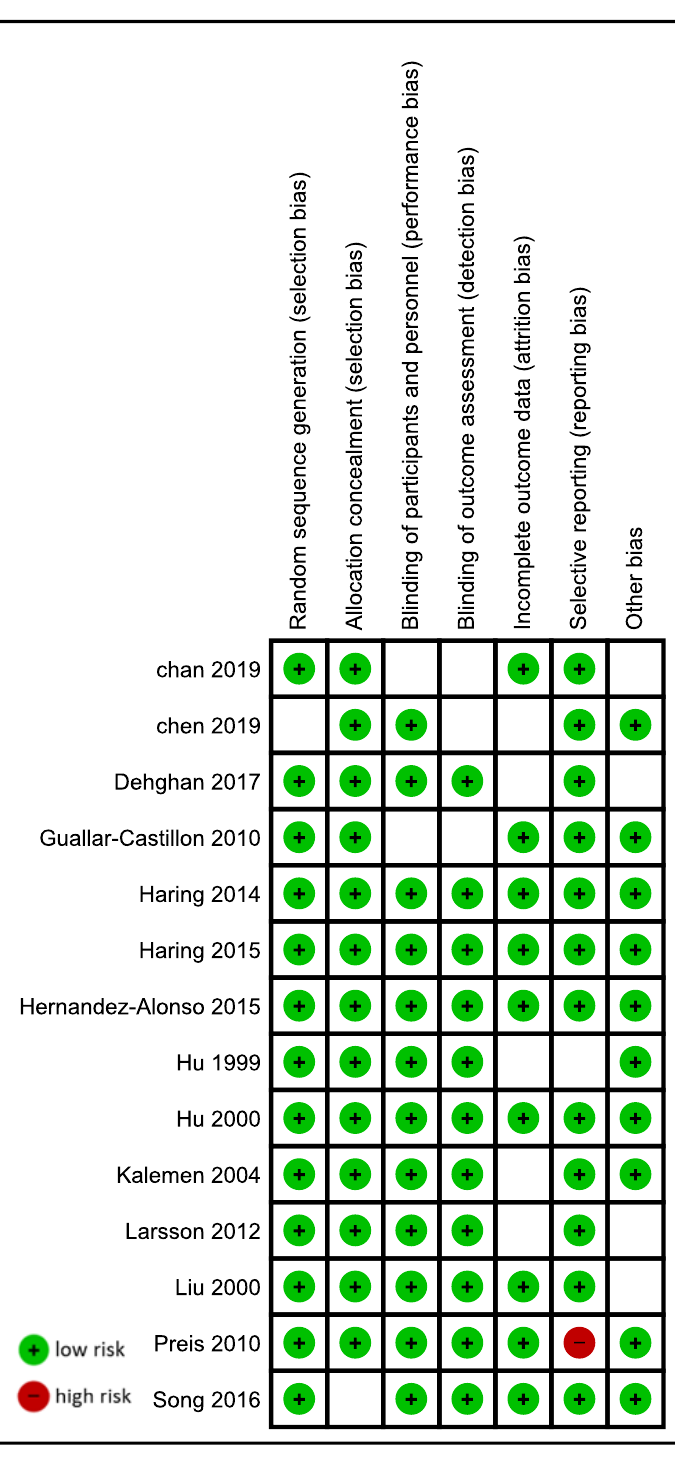
Figure 1. Summary of risk of bias assessment [13,15,23,49 –